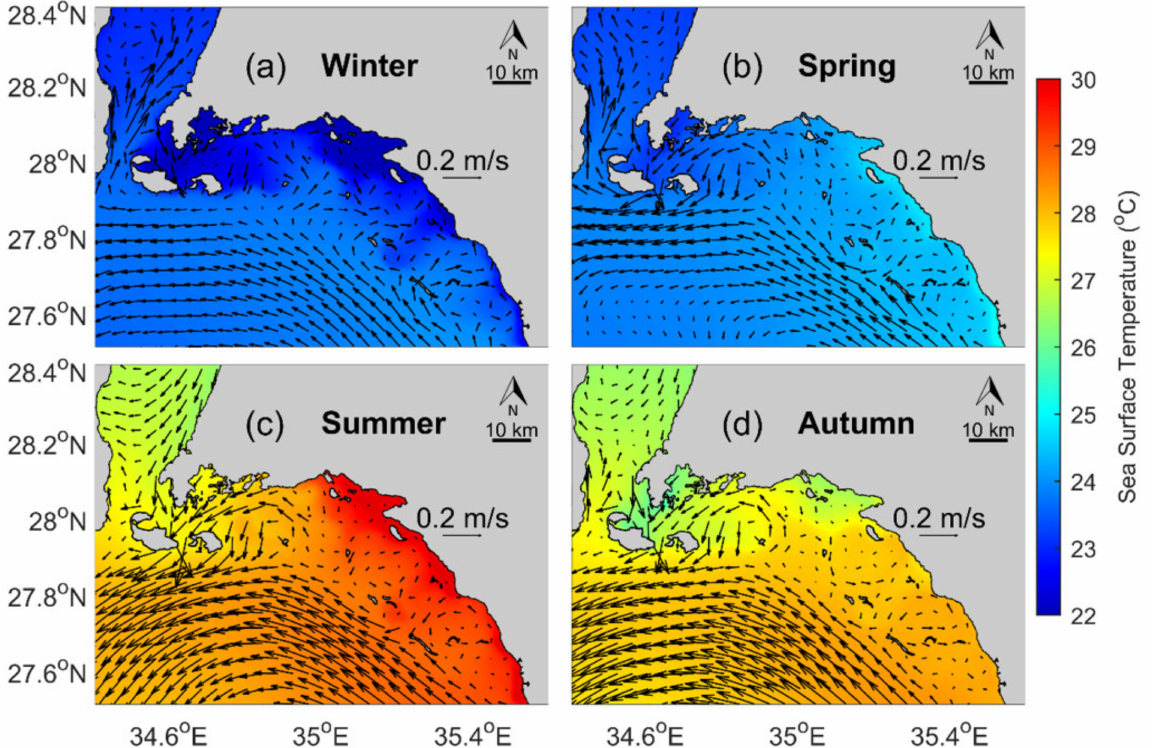
Figure 5. Mean water circulation velocity and SST of the study area, calculated from a hydrodynamic model running through 1980–2018, for seasons: ( a ) Winter: mid-December to mid-March, ( b ) Spring: mid-March to mid-May, ( c ) Summer: mid-May to mid-September, ( d ) Autumn: mid-September to